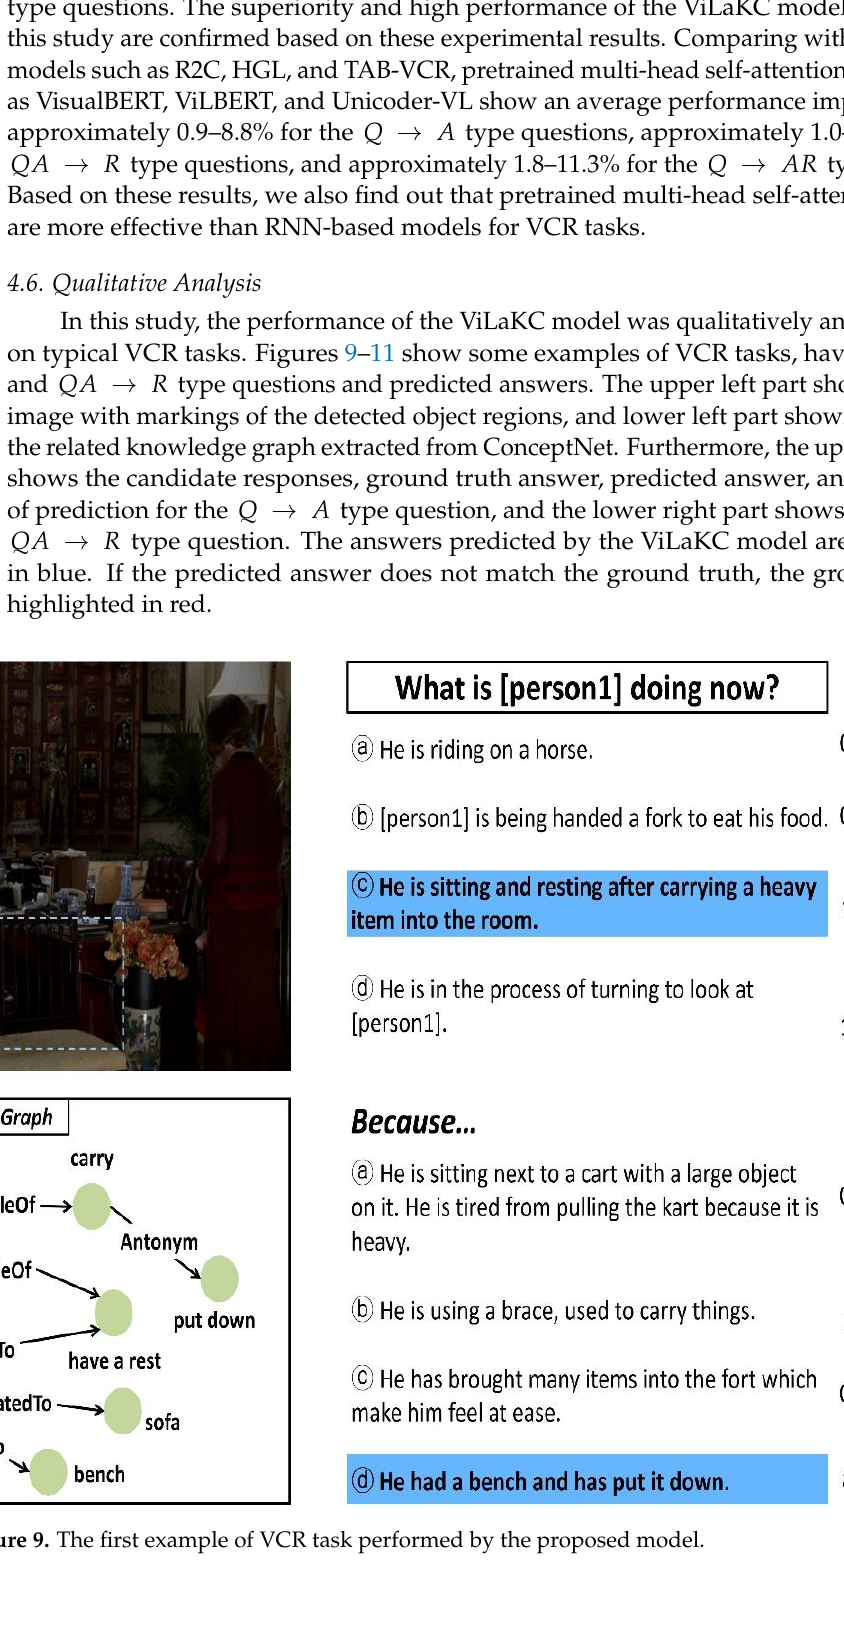
Figure 10. The second example of VCR task performed by the proposed model.